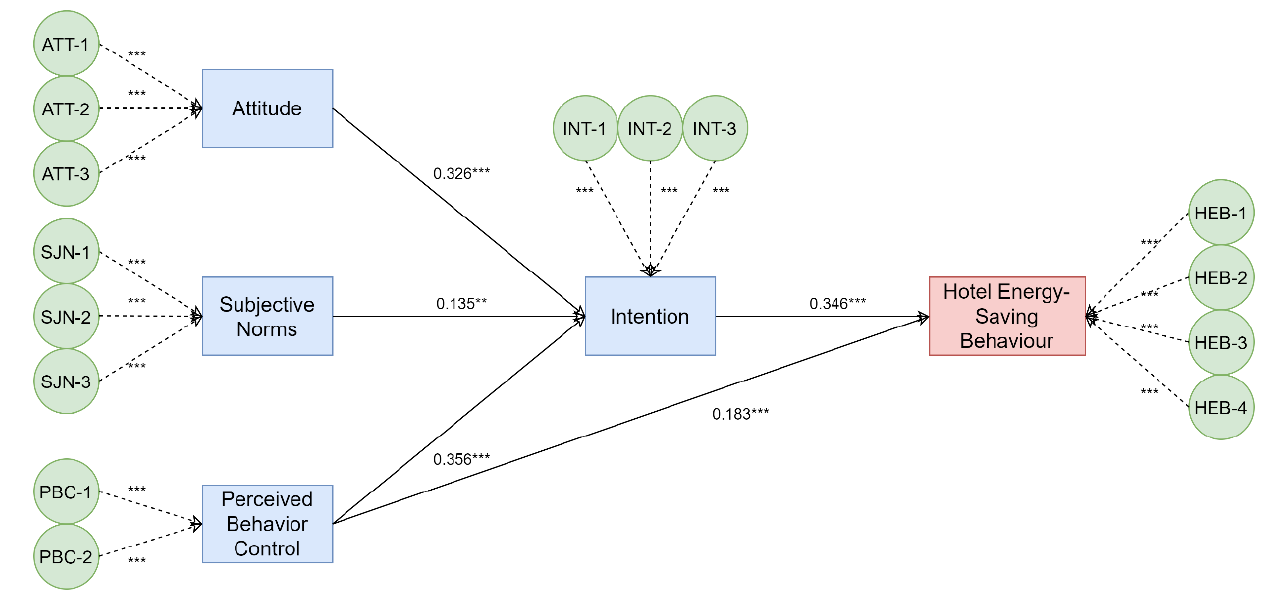
Figure 4. Structural modelling results of the TPB model. Note: *** p < 0.001; ** p < 0.001.